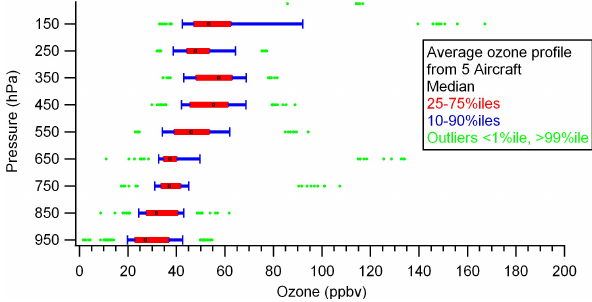
Fig. 9. Average vertical profile of ozone concentrations in bins of 100 hPa of atmospheric pressure based on 1-minute data from the BAe-146, the DLR Falcon, the French Falcon, French ATR and the M55 between 20 July and 21 August 2006. The black marker is the median, the red box the range of the 25 to 75 percentiles, the blue whiskers the range of the 10 to 90 percentiles and the green points outliers less than the 1 percentile and greater than the 99 percentile. Note that the x- axis is limited to 200ppbv to show the variation of ozone in the troposphere. Ozone concentrations in the top layer are limited to data between 100 and 50hPa bin and exceed